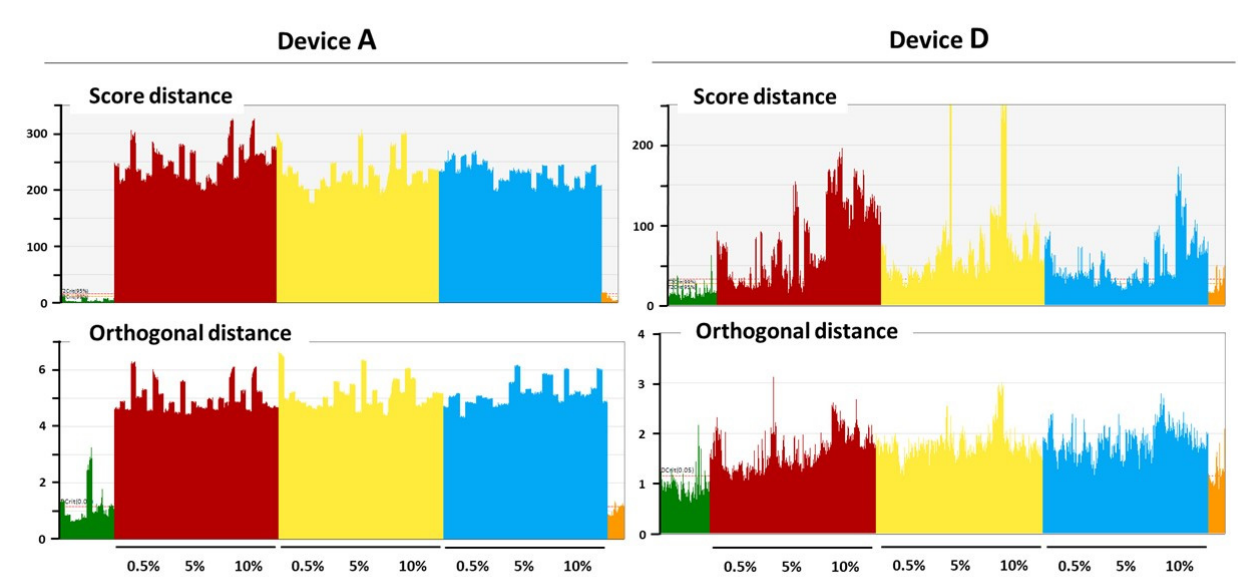
Figure 3. Score and orthogonal distances of control and adulterated wet-blended samples pro- jected onto an OCC SIMCA model of NIR spectra acquired with either device A (left panel) or device D (right panel) on respray-dried skimmed milk powders. Color codes of samples: Green: control; Red: ammonium sulfate-adulterated; Yellow: cornstarch-adulterated; Blue: semicarbazide- adulterated; Orange: buffalo/cow mixtures.